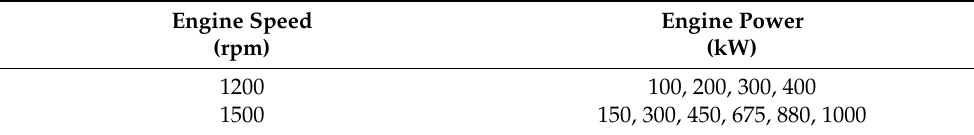
Table 3. Operation conditions for twelve-cylinder engine.